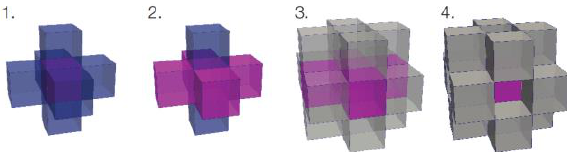
Figure 6: Edge neighbours - first step: face neighbours, second step: selected face neighbours, third step: compute face